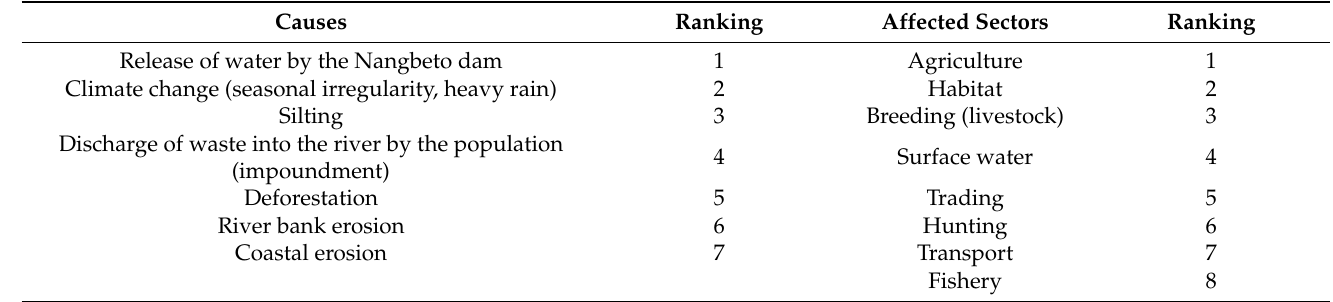
Table 1. Ranking of causes and most-affected sectors of floods according to local communities (rank 1 is the greatest weighted cause or affected, 7 is the least weighted).